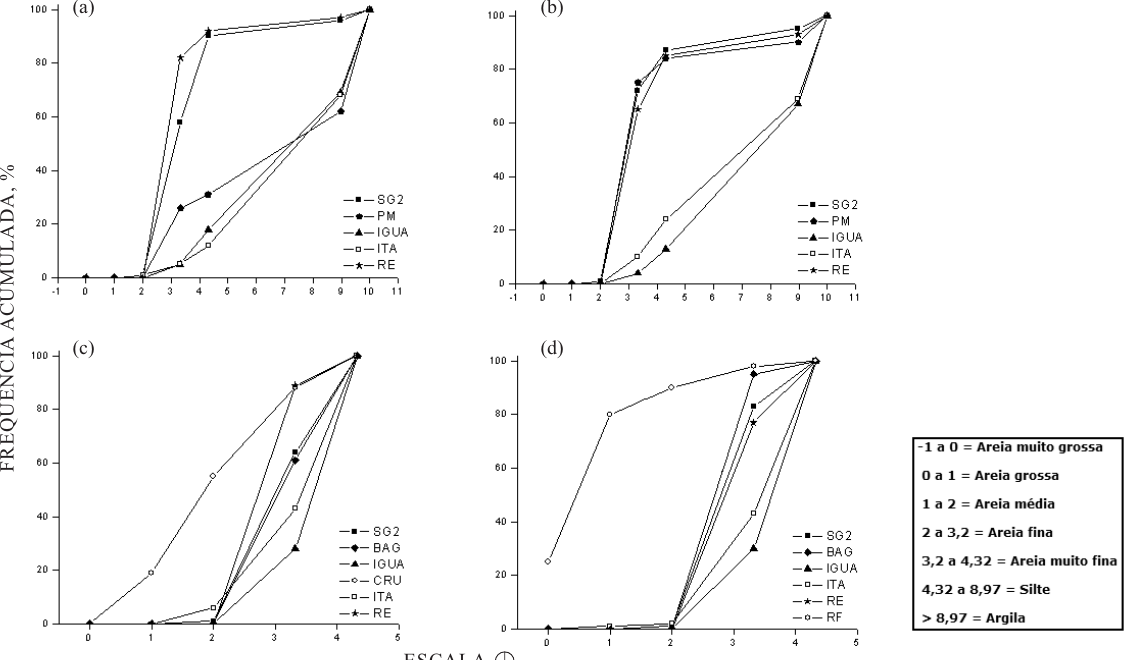
Figura 3. Curvas de freqüência acumulada das frações totais e frações da areia dos solos de manguezais ao longo do litoral paulista. (a) frações totais (0–20 cm); (b) frações totais (60–80 cm); (c) frações da areia (0–20 cm); e (d) frações da areia (60–80